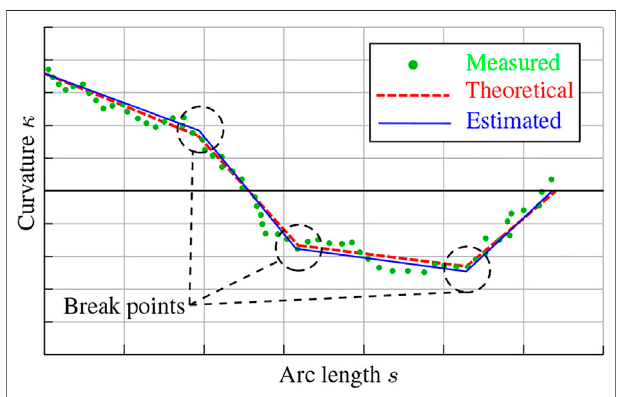
FIGURE 3 | Example plot illustrating the differences between the theoretical, measured, and estimated curvature pro fi les.